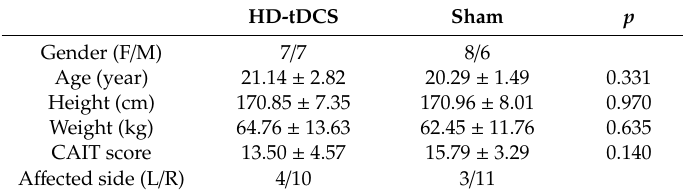
Table 1. Means and standard deviations for participant demographics.